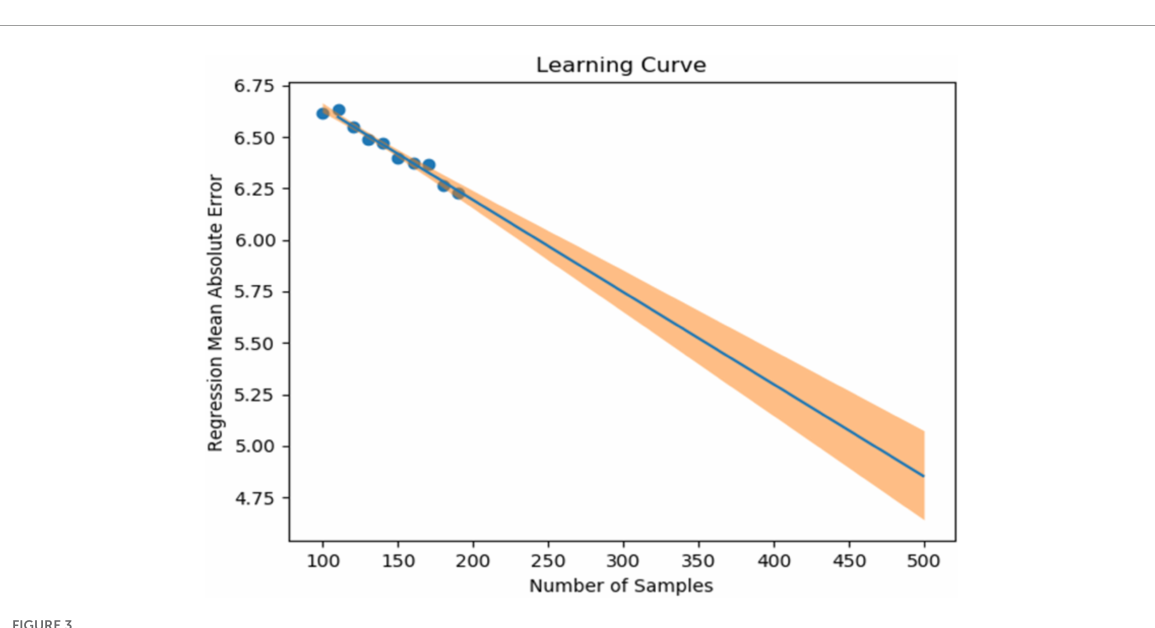
of cases will be adjusted upward or downward according to Adaptive